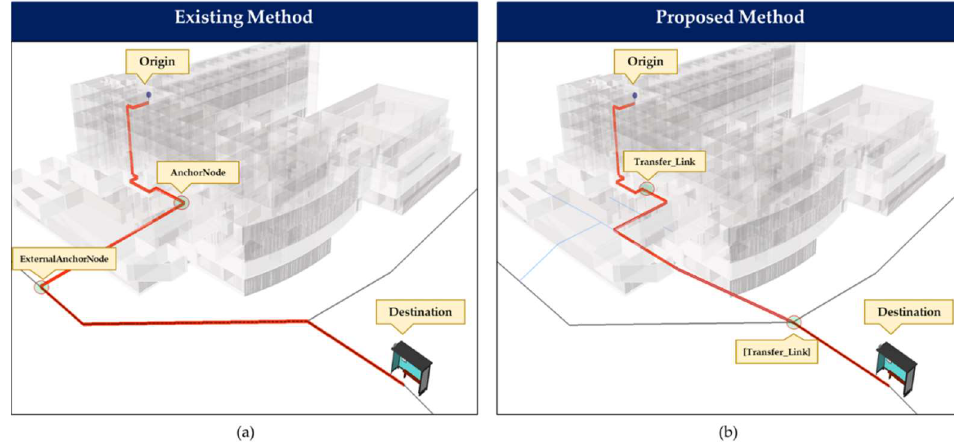
Figure 14. Comparing the results for the route analysis for the ( a ) current version of the IndoorGML SeamlessNavigation extension module and ( b ) proposed model.